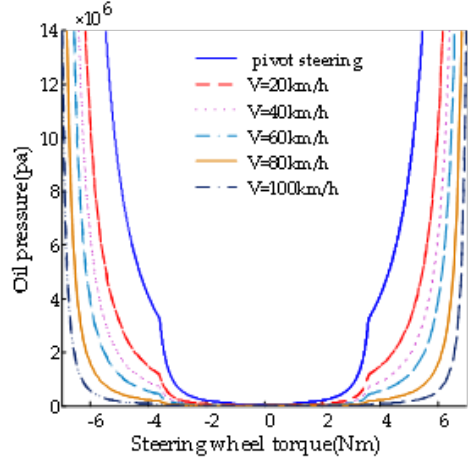
Figure 8. Ideal assist characteristic curve of P-ECHPS.